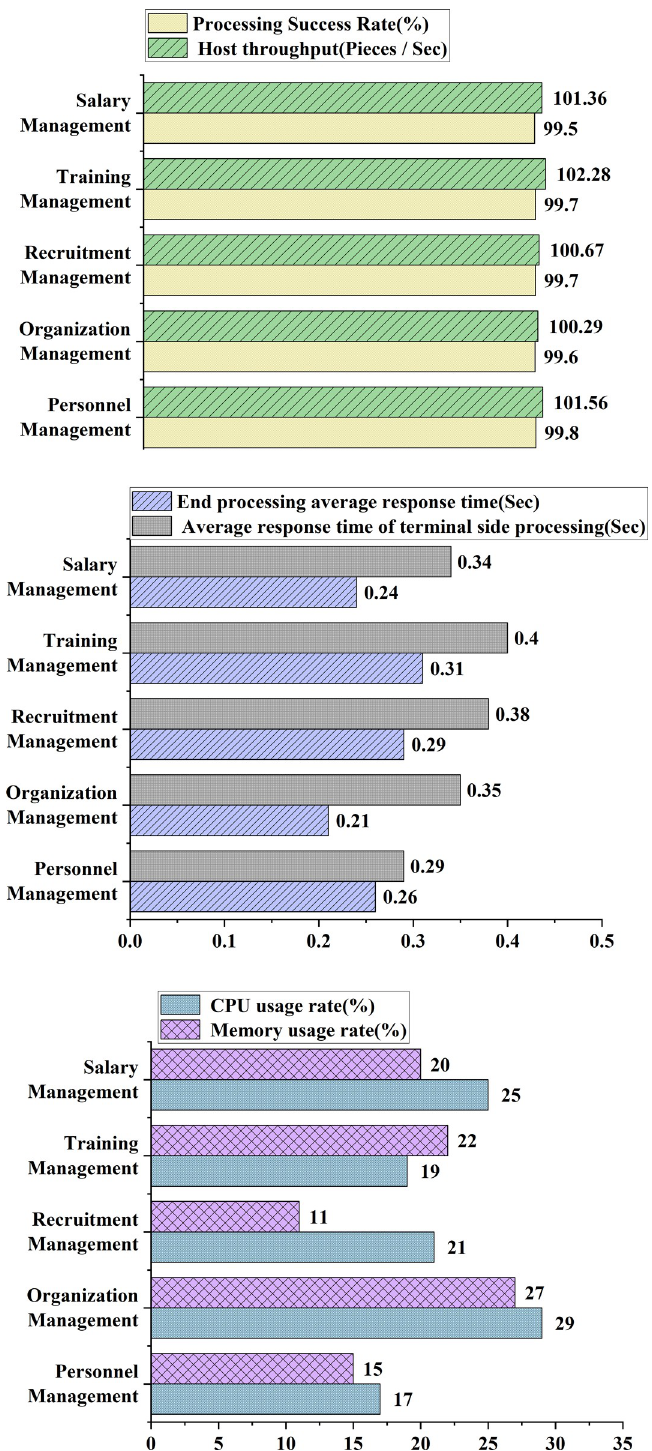
Fig 17. Results of performance test (a. Test results of throughput of system in business processing host and success rate of event processed; b. test results of average response time in business processing end and average response time in terminal side; c. test results of CPU occupancy and memory occupancy in system operation).